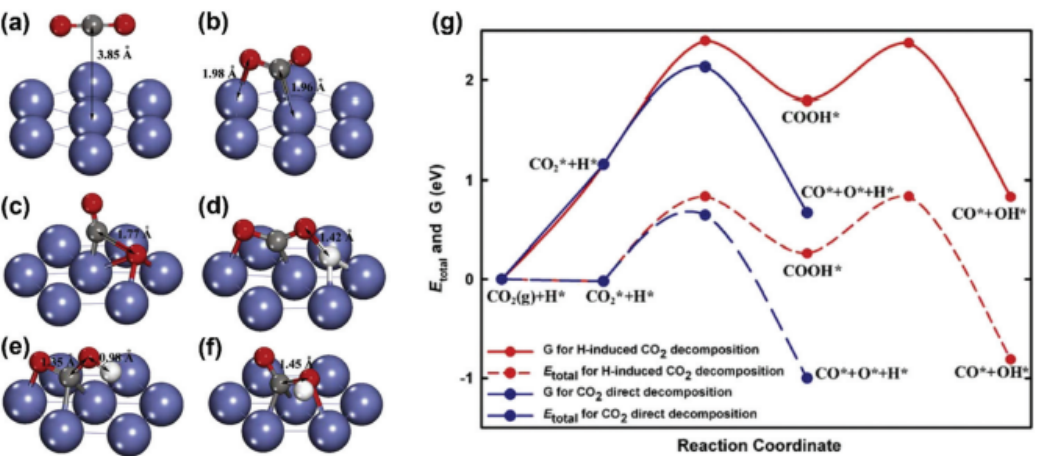
Figure 20. Geometries of ( a ) the physisorbed CO 2 on Ni(111), ( b ) the chemisorbed CO 2 on Ni(111), ( c ) the transition state for CO 2 decomposition via the direct pathway, ( d ) the transition state for the H-inducted CO 2 decomposition, ( e ) the intermediate for the H-induced CO 2 decomposition, and ( f ) the transition state for COOH dissociation to generate CO and OH, along with the ( g ) total energy and Gibbs free energy diagrams for the CO 2 direct decomposition and H-induced CO 2 decomposition on Ni(111). Reprinted with permission from Ref. [270]. Copyright 2009 Elsevier.